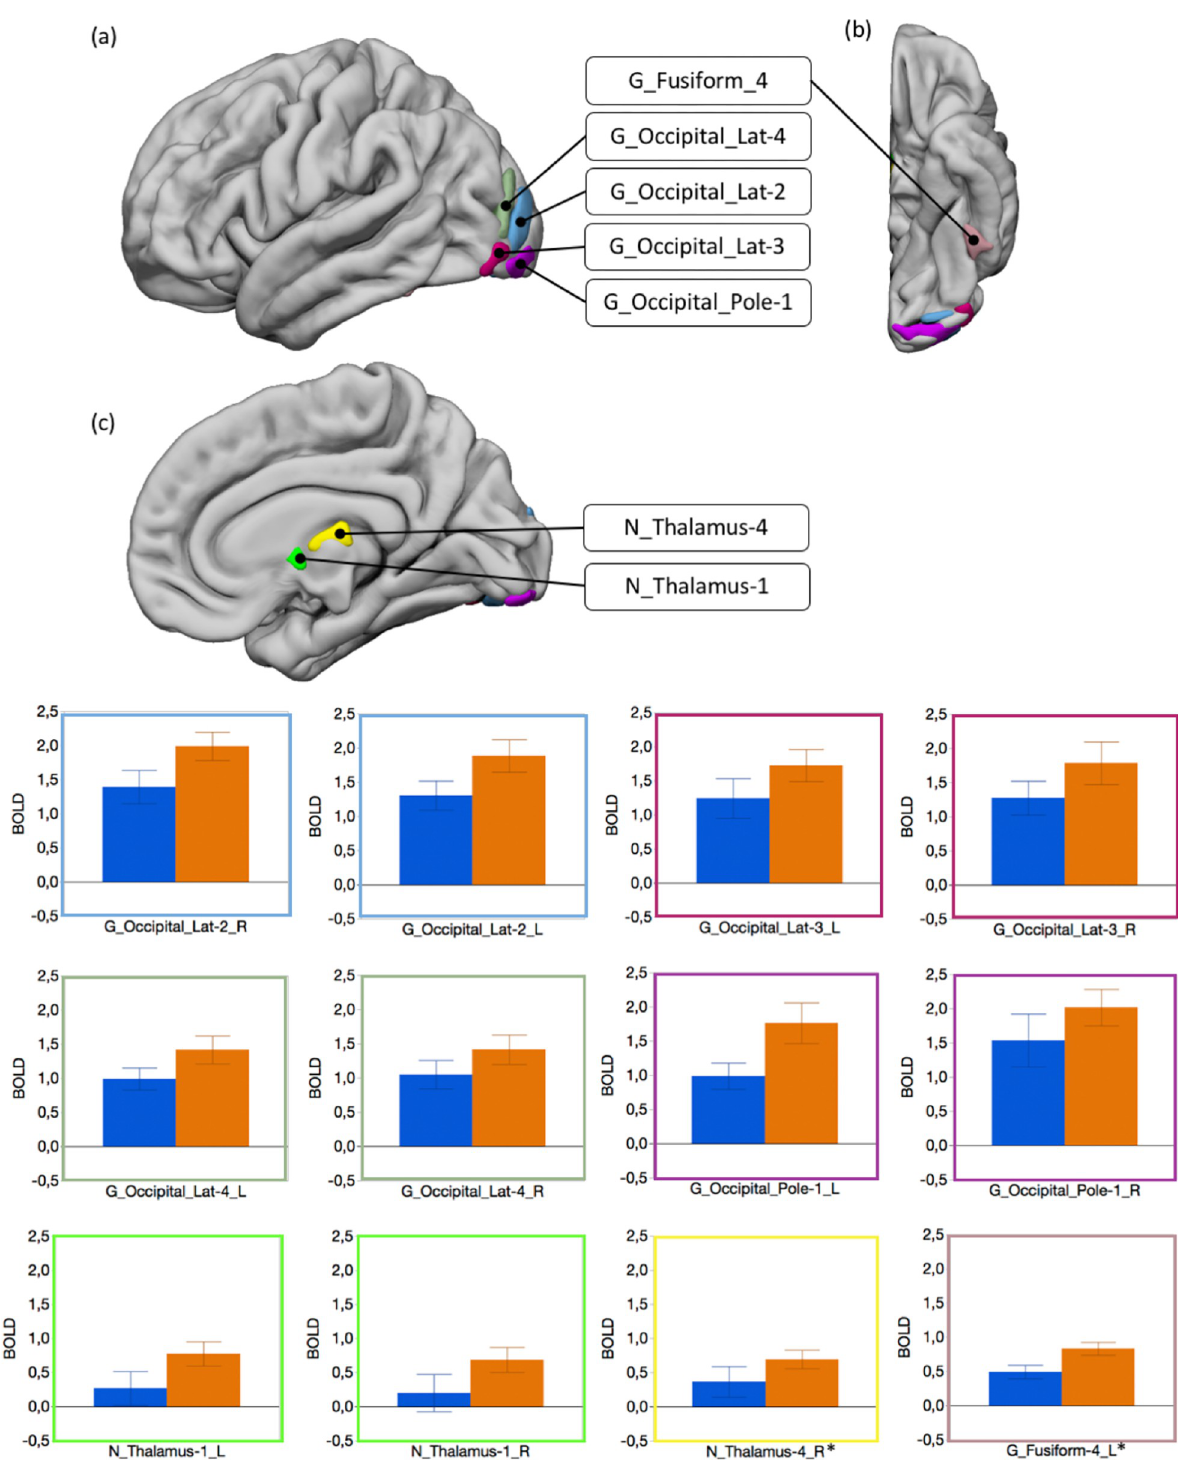
Fig 5. Experts compared to controls in the judgment task. Top: hROIs that showed a greater activity in Experts than in Controls. � : G_Fusiform- 4_L and N_Thalamus-4_R were significant at uncorrected threshold only (p uncorr = 0.015 and puncorr = 0.019, respectively). (a) Lateral view of the left hemisphere. (b) Inferior view of the left hemisphere. (c) Medial view of the left hemisphere. Bottom: plots of the BOLD values in these regions in Controls (blue) and Experts (orange). Error bars represents the confidence interval (95%).